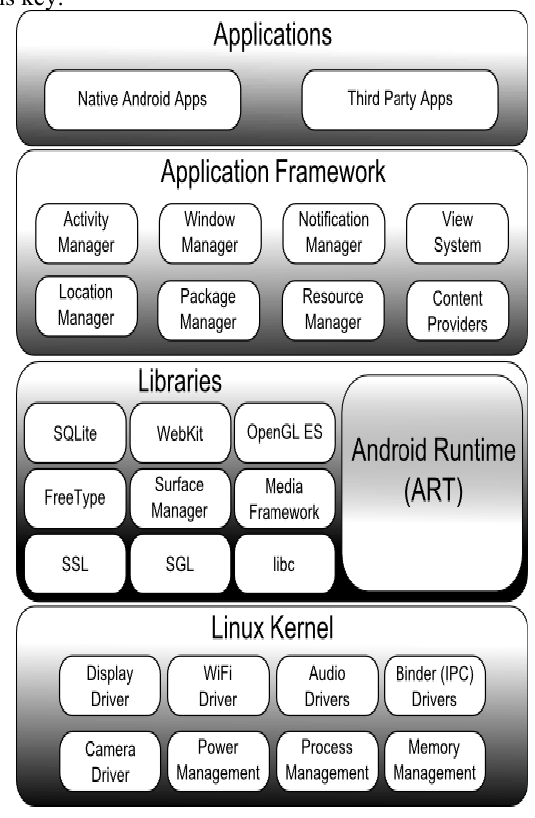
Figure 1. Current Android